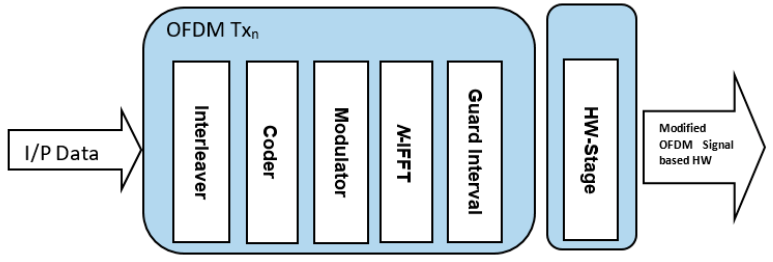
Figure 5. Suppressing the side-lobes based on the W-DFT process. Figure 6. The communication link modification based on the wavelet-stage.